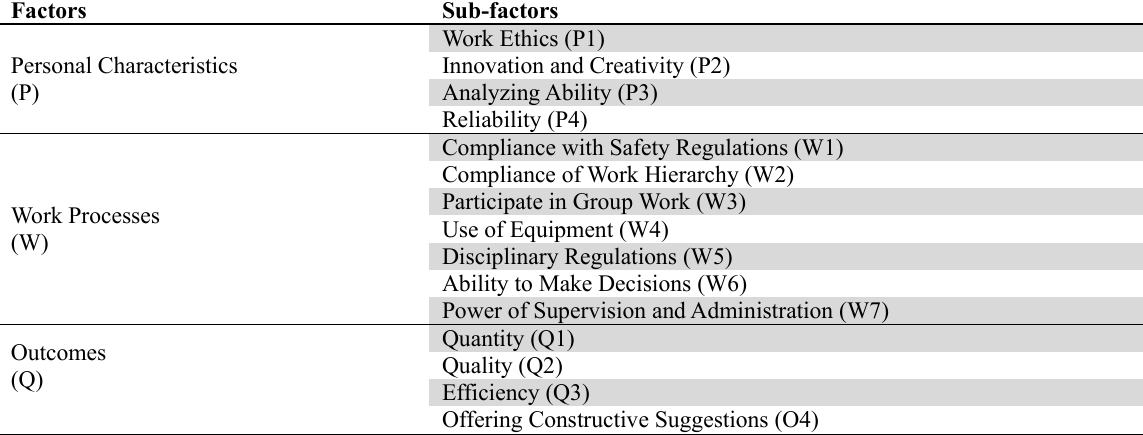
Factors and sub-factors used in the